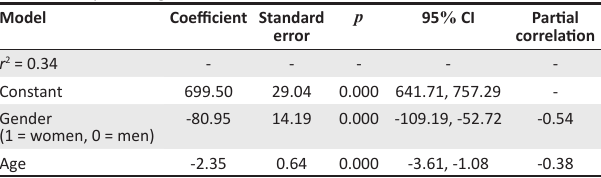
TABLE 3: Stepwise regression results. Model Coefficient Standard